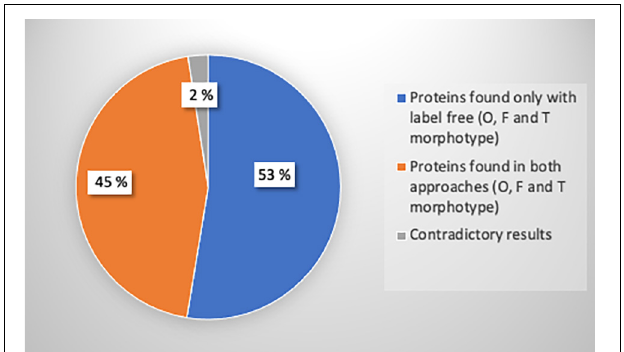
FIGURE 8 | Pie chart representing the number of proteins identified with iTRAQ R (cid:13) , label-free or both methods, and the proportion of contradictory results. A total of 696 proteins were identified with label-free analysis ( p -value ≤ 0.05): 648 proteins for oval, 32 proteins for fusiform, and 16 proteins for triradiate morphotypes. A total of 330 proteins were identified with iTRAQ R (cid:13) analysis. Among these proteins, 17 proteins representing 2% of iTRAQ R (cid:13) identified proteins were differentially regulated between both